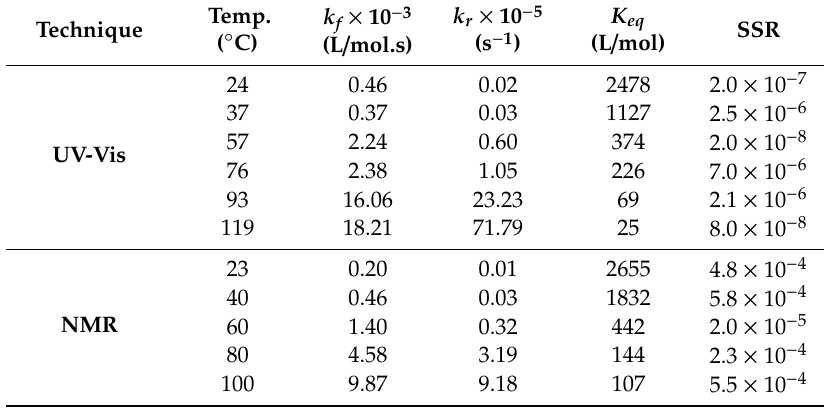
Table 1. Diels–Alder kinetic and thermodynamic constants for reaction FAL–NHM. Technique